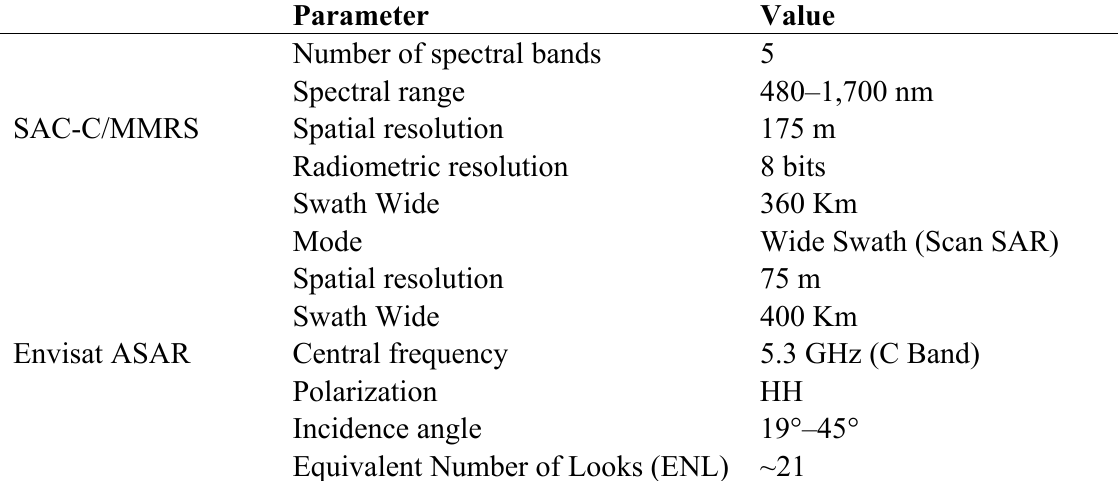
Table 1. Characteristics of satellite data